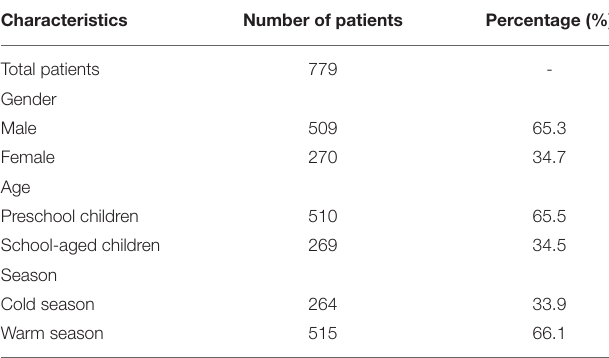
TABLE 1 | Descriptive statistics of hospital admissions for childhood asthma in Beijing, China